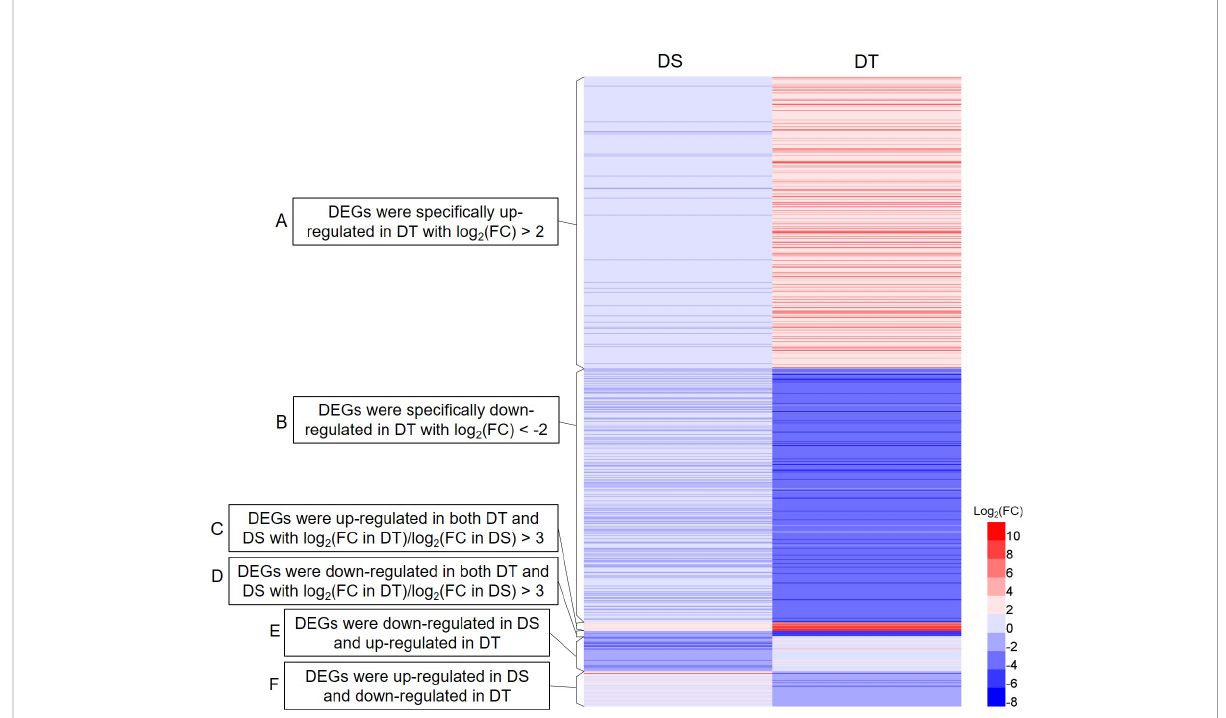
FIGURE 3 Heatmap of the expression of 1025 drought resistance-related DEGs. DS, drought-sensitive variety JM38, DT, drought-tolerant variety ZM13. (A) DEGs were speci fi cally up-regulated in DT with log 2 (fold change in DT) > 2. (B) DEGs were speci fi cally down-regulated in DT with log 2 (fold change in DT) < -2. (C) DEGs were up-regulated in both DT and DS with log 2 (fold change in DT)/log 2 (fold change in DS) > 3. (D) DEGs were down-regulated in both DT and DS with log 2 (fold change in DT)/log 2 (fold change in DS) > 3. (E) DEGs were down-regulated in DS and up- regulated in DT. (F) DEGs were up-regulated in DS and down-regulated in